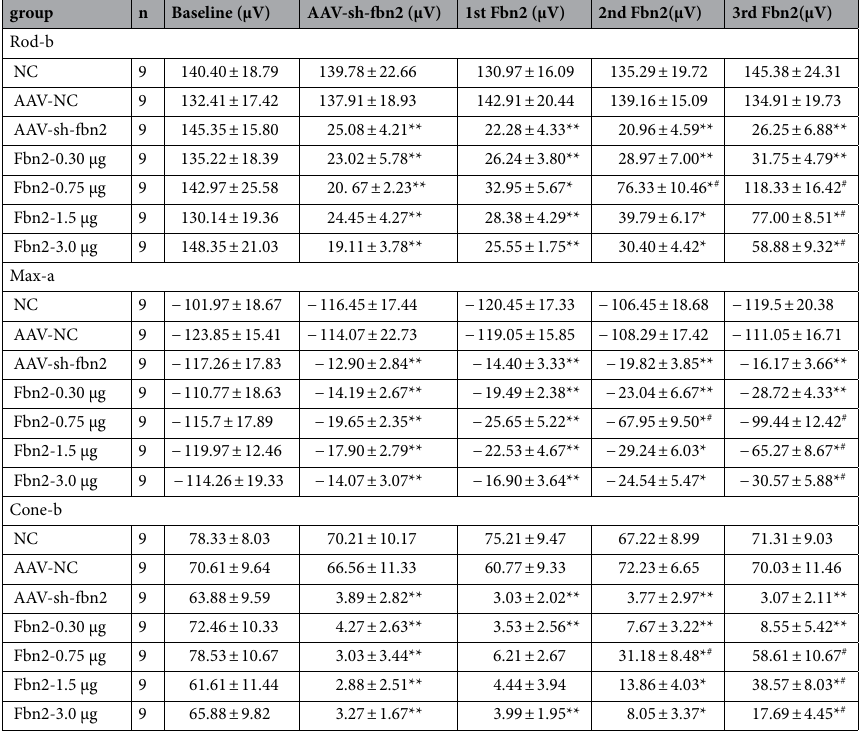
out, the mean rod b-wave amplitude was significantly higher in eyes with intravitreal injections of fbn2 recombi- nant protein in doses of 0.75 μg, 1.5 μg and 3.0 μg (group #5, group #6 and group #7) than in the eyes with intra- vitreal injections of AAV-sh-fbn2 only or in eyes without any further injections (group #3) (118.33 ± 16.42 μV vs. 26.25 ± 6.88 μV; P < 0.001; 77.00 ± 8.51 μV vs. 26.25 ± 6.88 μV; P = 0.02; 58.88 ± 9.32 μV vs. 26.25 ± 6.88 μV; P = 0.03; respectively). The rod b-wave amplitude did not differ significantly between eyes with three intravitreal injections of fbn2 recombinant protein in a dose of 0.75 μg (group #5), eyes without any intervention (group #1), and eyes with intravitreal injections of AAV empty vector and without any further treatment (group #2) (Table 1) (Fig. 2). Fbn2 recovered the maximal (Max) a‑wave amplitude. All groups did not differ significantly in the mean amplitude of Max a-wave at baseline (all P > 0.05) (Table 1) (Fig. 2). At 2 weeks after baseline, the mean amplitude of Max a-wave was significantly lower in eyes with the intravitreal injection of AAV-sh-fbn2 (groups #3–7) than in the eyes with the intravitreal injection of an AAV-empty vector only (group #2) (all P < 0.001). After three intravitreal injections of the fbn2 recombinant protein, the mean amplitude of Max a-wave was signifi- cantly higher in the eyes with the intravitreal injection of fbn2 recombinant protein applied in doses of 0.75 μg, 1.5 μg and 3.0 μg (groups #5, #6 and #7) than in the eyes with an intravitreal injection of AAV-sh-fbn2 and without any further injections (group #3) (− 99.44 ± 12.42 μV vs. − 16.17 ± 3.66 μV; P < 0.001; − 65.27 ± 8.67 μV vs. − 16.17 ± 3.66 μV; P = 0.02; − 30.57 ± 5.88 μV vs. − 16.17 ± 3.66 μV; P = 0.03). The Max a-wave amplitude did not differ significantly between the eyes with three intravitreal injections of fbn2 recombinant protein in a dose of 0.75 μg (group #5) as compared with eyes without any intervention (group #1) or as compared with the eyes with intravitreal injection of AAV empty vector and without any further injections (group #2) (Table 1) (Fig. 2).